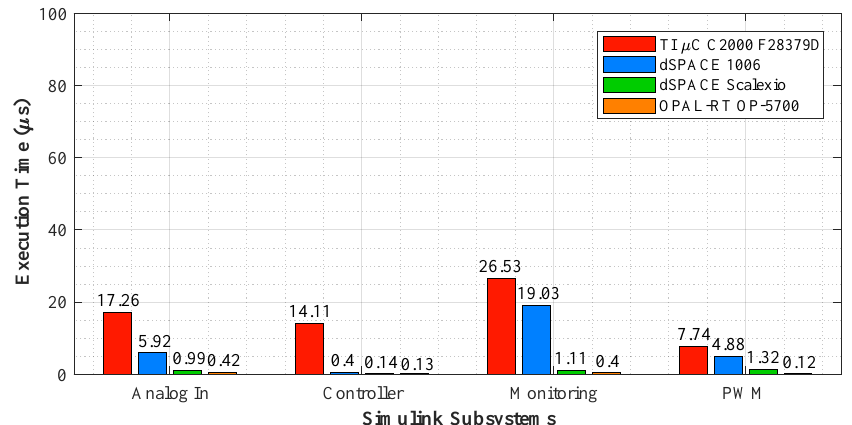
Figure 13. Computation time profiles for the PR ( αβ ) controller of the Debugged version